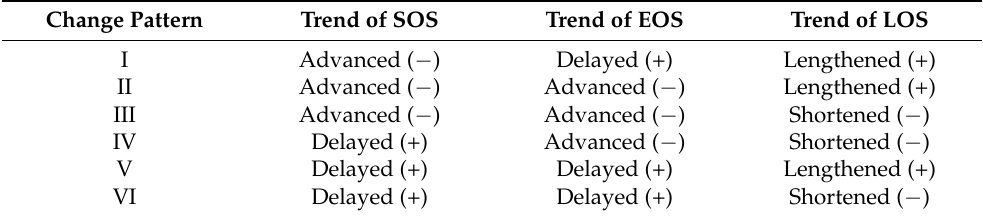
Table 2. Six change patterns of plant growing seasons, i.e., six combination types of SOS, EOS, and LOS change trends. The plus and minus signs represent the trend direction corresponding to SOS, EOS, or LOS, respectively. Change Pattern Trend of SOS Trend of EOS Trend of LOS I Advanced ( − ) Delayed (+) Lengthened (+)